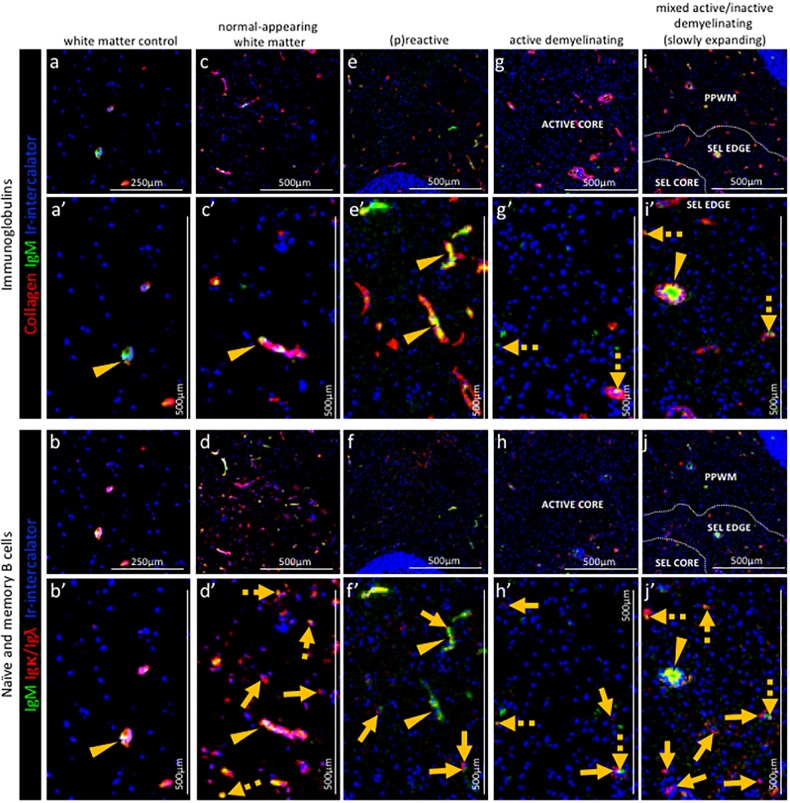
Pattern of immunoglobulins and B cell subpopulations in different stages of MS lesions by IMC.Representative mass cytometry images of (a, a’, b, b’) white matter of control, (c, c’, d, d’) normal-appearing white matter (block no. CR4A), (e, e’, f, f’) a (p)reactive lesion (block no. CR4A), (g, g’, h, h’, o) an active demyelinating lesion (block no. CR4A) and (i, i’, j–n) a mixed active-inactive demyelinating lesion (block no. CL3A). For each region of interest, we show the same area simultaneously labeled with markers of endothelial cells (collagen) to detect blood vessels, immunoglobulin M (IgM), the κ or λ light chain of immunoglobulins (Igκ/Igλ) to detect B cells and DNA (Ir-intercalator). (a, a–i, i’) Overlay of collagen (red), IgM (green) and Ir-intercalator (blue) identifies cellular (intercalator-associated, dotted arrows in g’ and i’) and non-cellular (free immunoglobulin, arrows head in a’, c’, e’, i’) IgM in the parenchyma or within collagen+ blood vessels. (b, b’–j, j’) Overlay of IgM (green), Igκ/Igλ (red) and Ir-intercalator (blue) identifies (dotted arrow in d’, h’ and j’) Igκ/Igλ+IgM+ naïve and IgM memory B cells and (solid arrows in d’, f’, h’ and j’) Igκ/Igλ+IgM- class switch B cells.